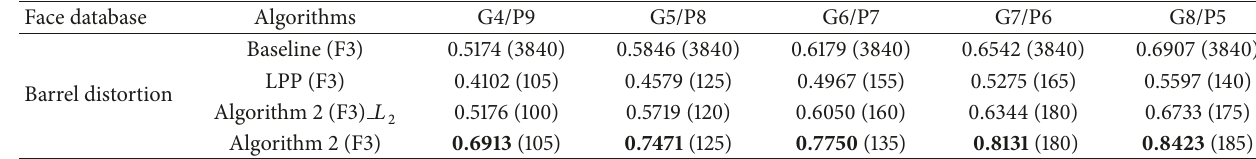
Table 12: The recognition rates on barrel distortion AR face database over “F3” features; recognition rates (dimensionality). Face database